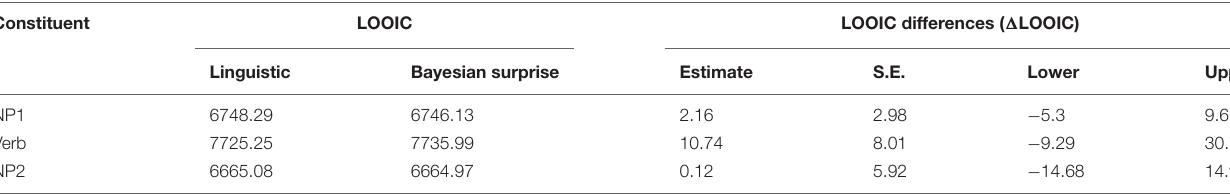
TABLE 5 | Out-of-sample predictive accuracy of linguistic and Bayesian surprise LMMs for each sentence region. Constituent LOOIC LOOIC differences ( (cid:49) LOOIC) Linguistic Bayesian